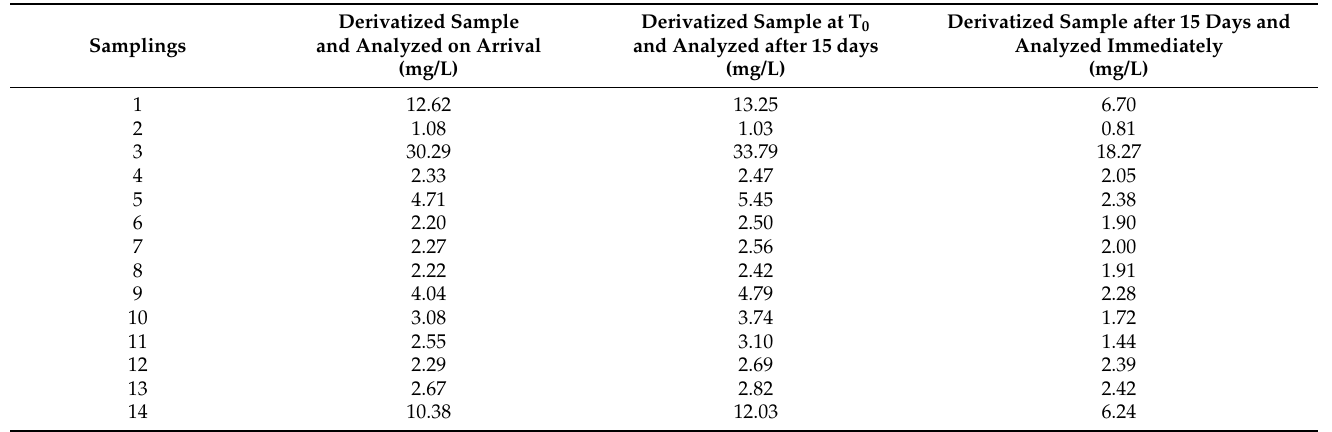
Table 10. Concentration of H − CHO analyzed by Lab. RSE during the First